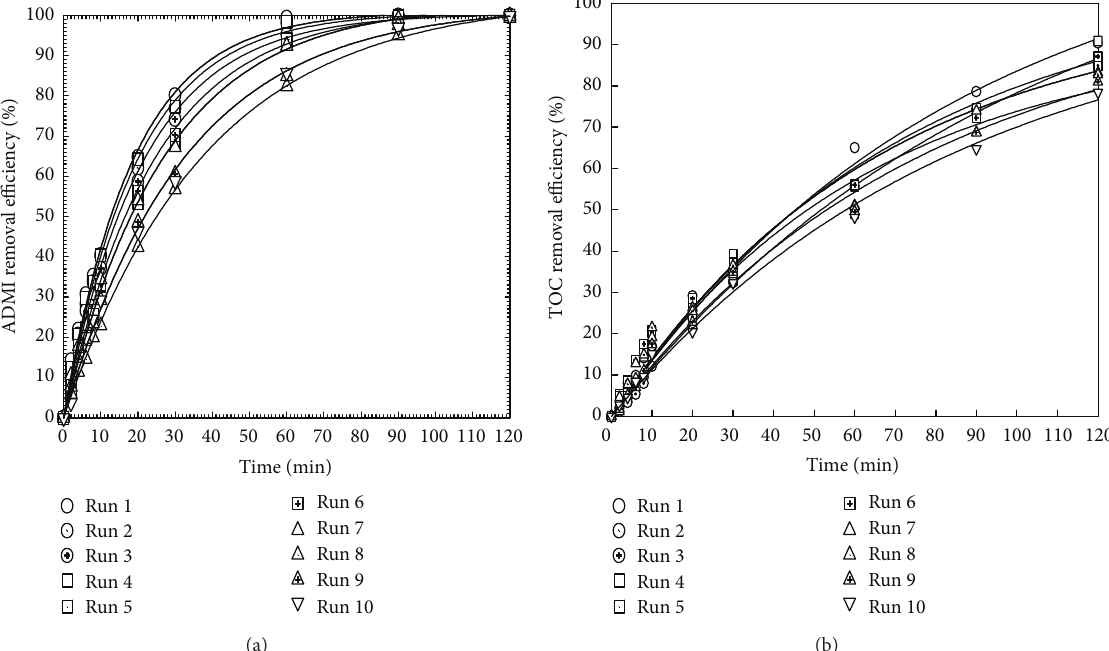
Figure 12: Duration test on (a) color and (b) TOC removal. The conditions were initial dye concentration of 50mg L −1 , ZnO-coated amounts of 60 gm −2 , light intensity of 2.1 mWcm −2 , and reaction time during 120